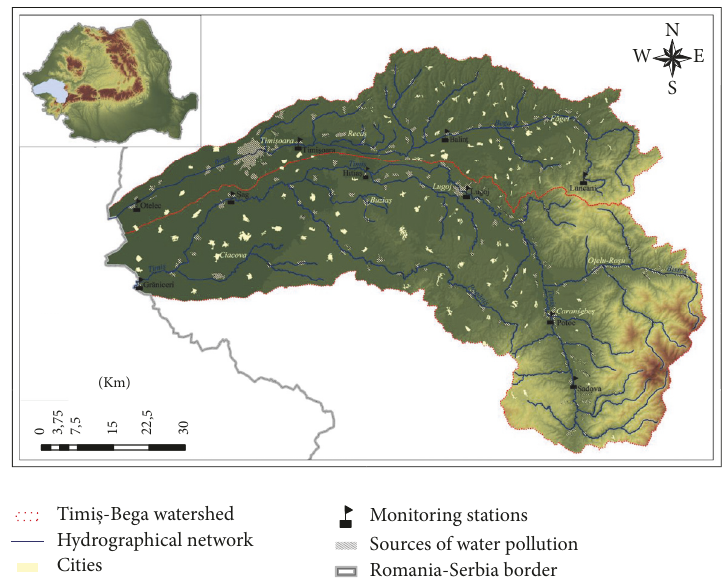
Figure 1: The geographical position of the Timis¸-Bega hydrographical basin within